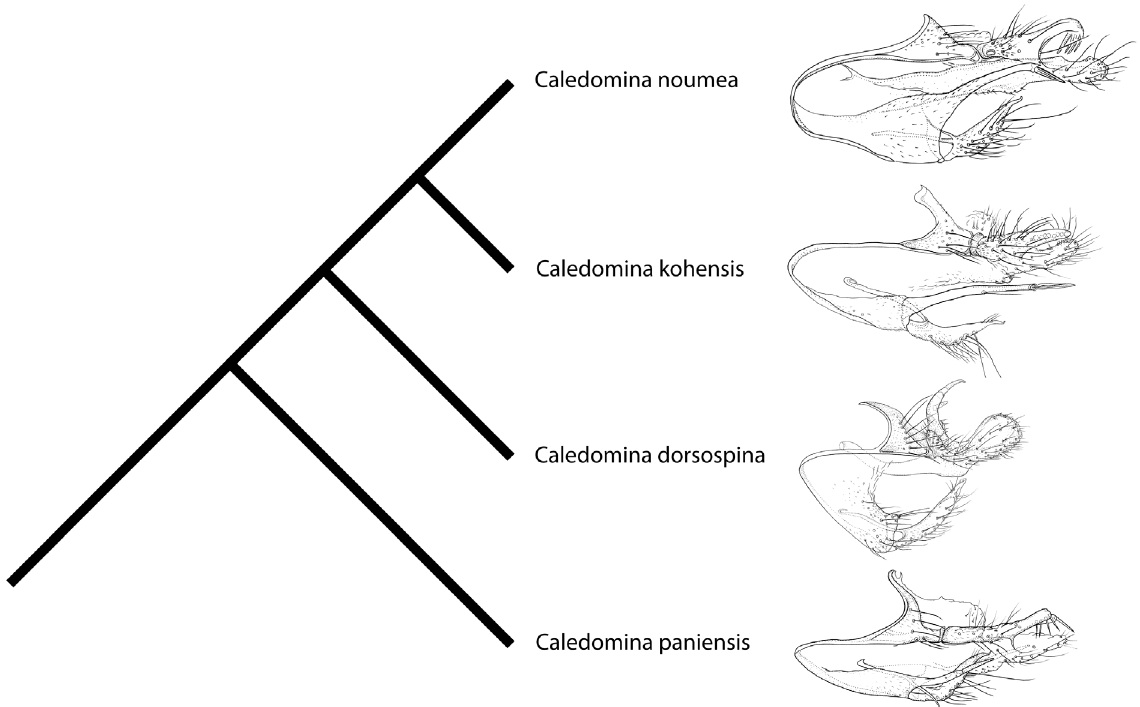
Fig. 19. Phylogenetic relationship among species of Caledomina , with morphology of male genitalia in lateral view to the